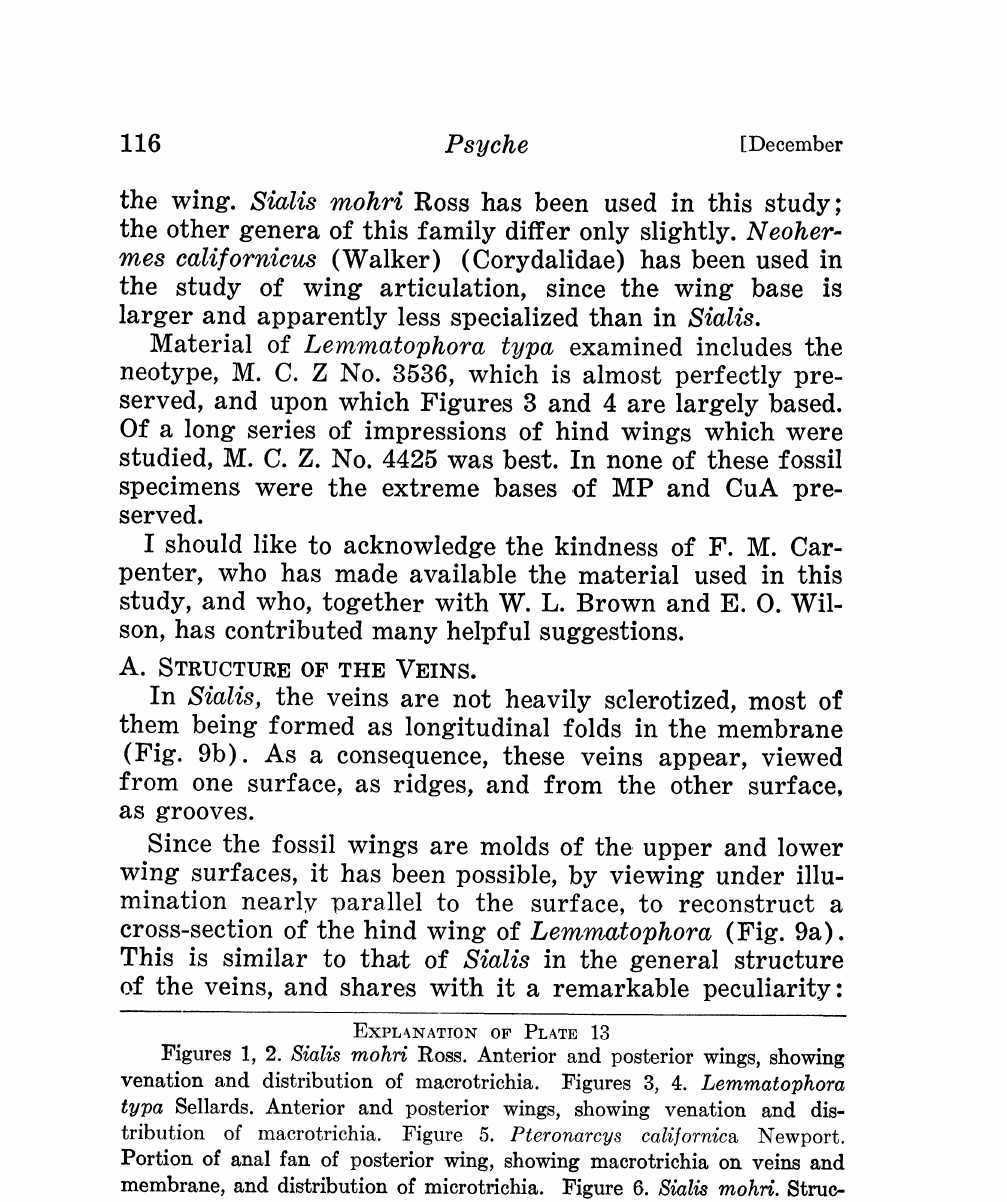
Figure 8. Lemmatophora typa. Portion of anterior wing, showing distribution of macrotrichia and microtrichia. (Pigmentation indicated by